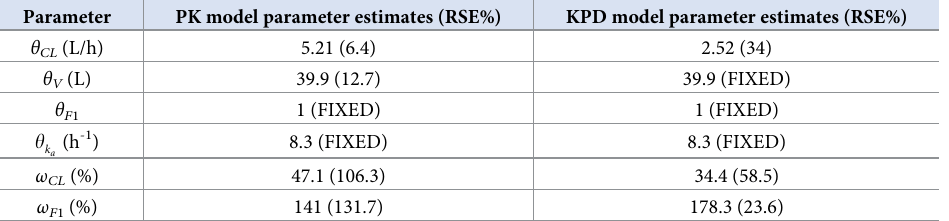
Table 4. Parameter estimates of the final pharmacokinetic model and kinetic-pharmacodynamic model with lin- ear linker model (separated model parameters for each patient group) used for